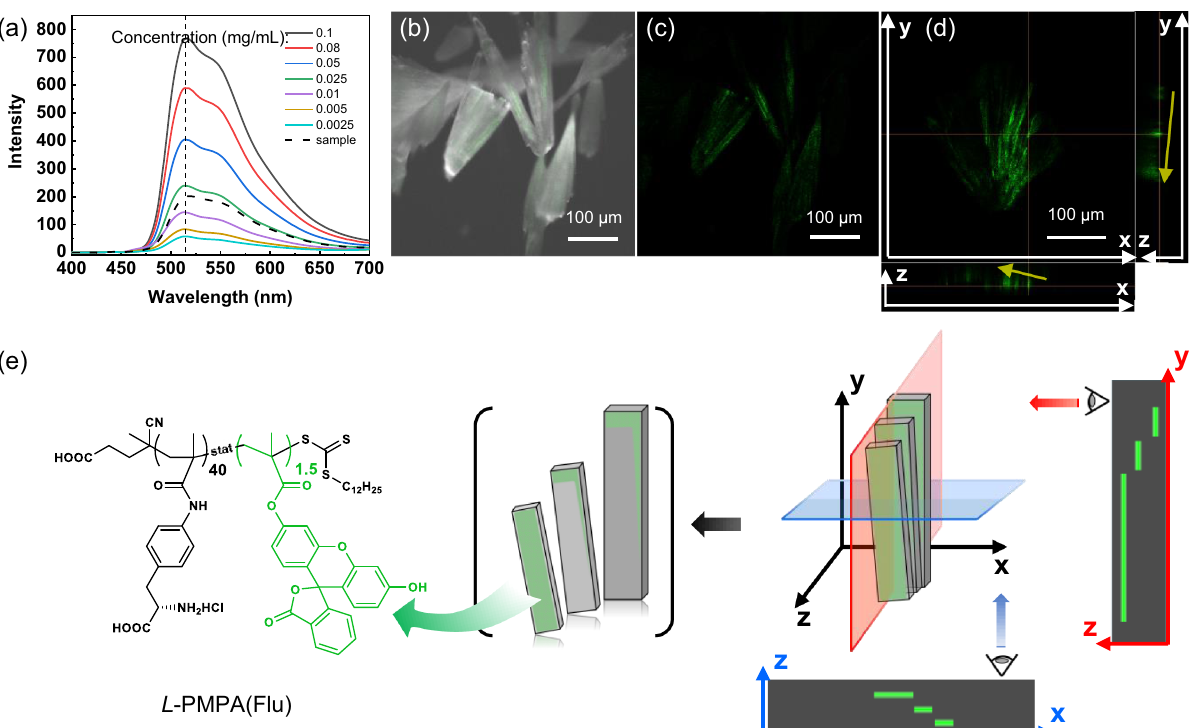
Fig. 4 The residual amount of L -PMPA(Flu) and their distribution in the crystal aggregates of D - p Hpg p Ts. a Fluorescence emission spectrum of L- PMPA(Flu) aqueous solutions with different concentration (0.0025 – 0.1 mg/mL), the dashed line is the curve of crystal sample (100 mg crystals dissovled in 10 mL H 2 O). b Merged picture of optical micrograph and fl uorescence image of fan-shaped crystal aggregates of D - p Hpg p Ts when 1.5 wt % L- PMPA(Flu) was used as the additive. c The corresponding 2D confocal fl uorescence micrographs. d The 3D confocal fl uorescence pro fi le of one fan-shaped D- crystal. e The model for the situation that no polymers exist between two crystalline platelets but only on the surface of the whole fan-shaped crystal, and the corresponding fl uorescein patterns on the cross-sections (blue plane: cross-section in y direction; red plane: cross-section in x direction). The crystal habit was simpli fi ed to a rectangular block for better classi fi cation. The molecular structure of L -PMPA(Flu) is illustrated on the